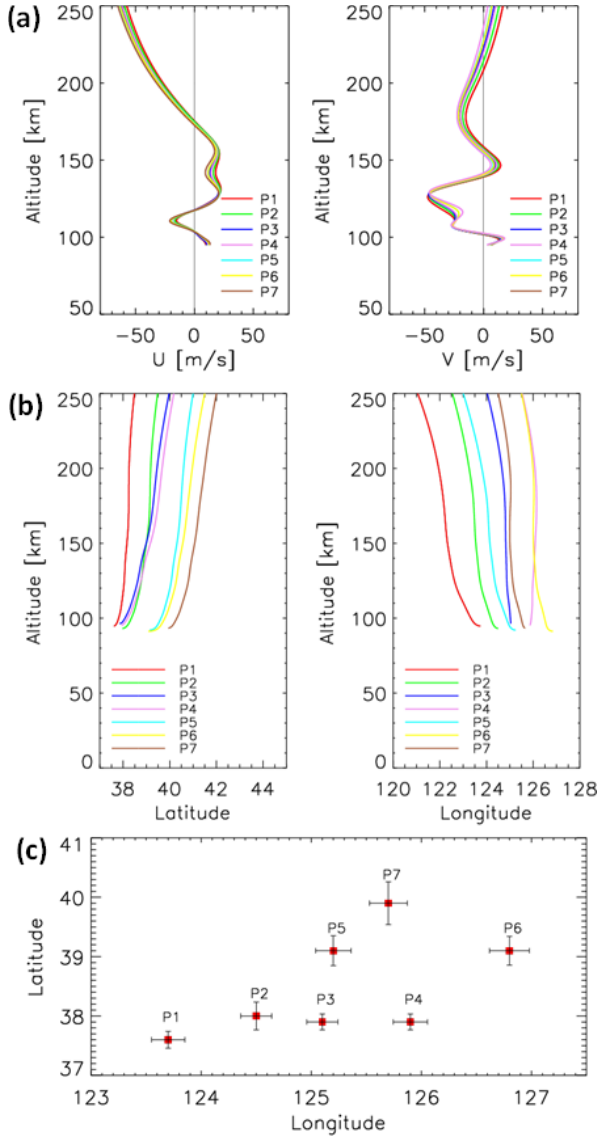
Figure 8. (a) Wind profiles along the seven ray-tracing paths. (b) Ray paths of the wave starting from the seven sampling points in Fig. 6. (c) Horizontal area distribution of the terminal positions of the seven backward-traced trajectories. Error bars give the standard deviation for each point from the starting altitudes of 240, 250, and 260km.